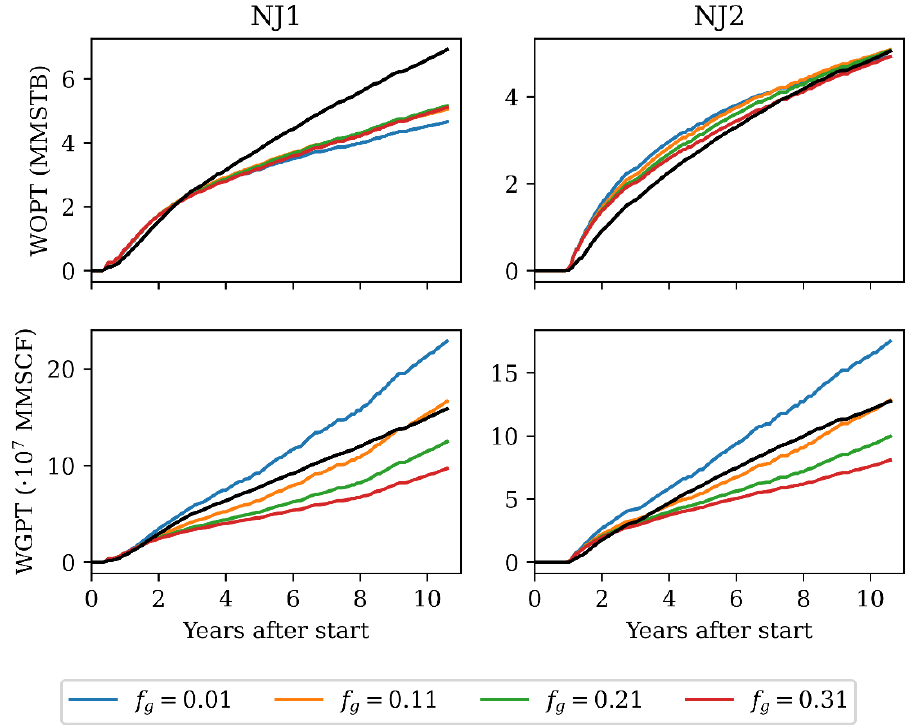
Figure 14. The production volumes for the North Jens model, corresponding to the different relative permeabilities in Figure 13. Black lines denote historical data.